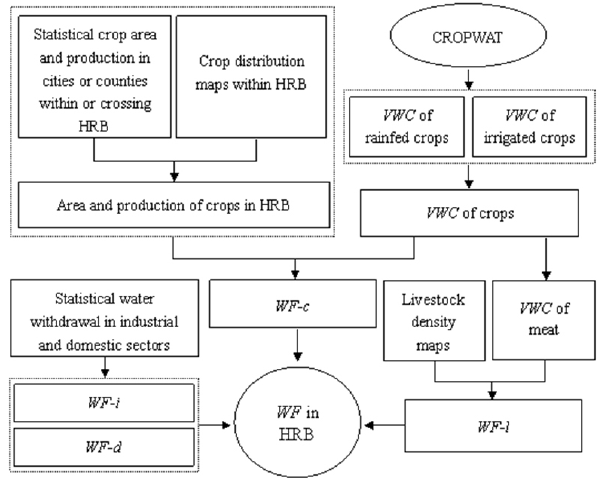
Fig. 2. The steps to calculate water footprint (WF) in the HRB.